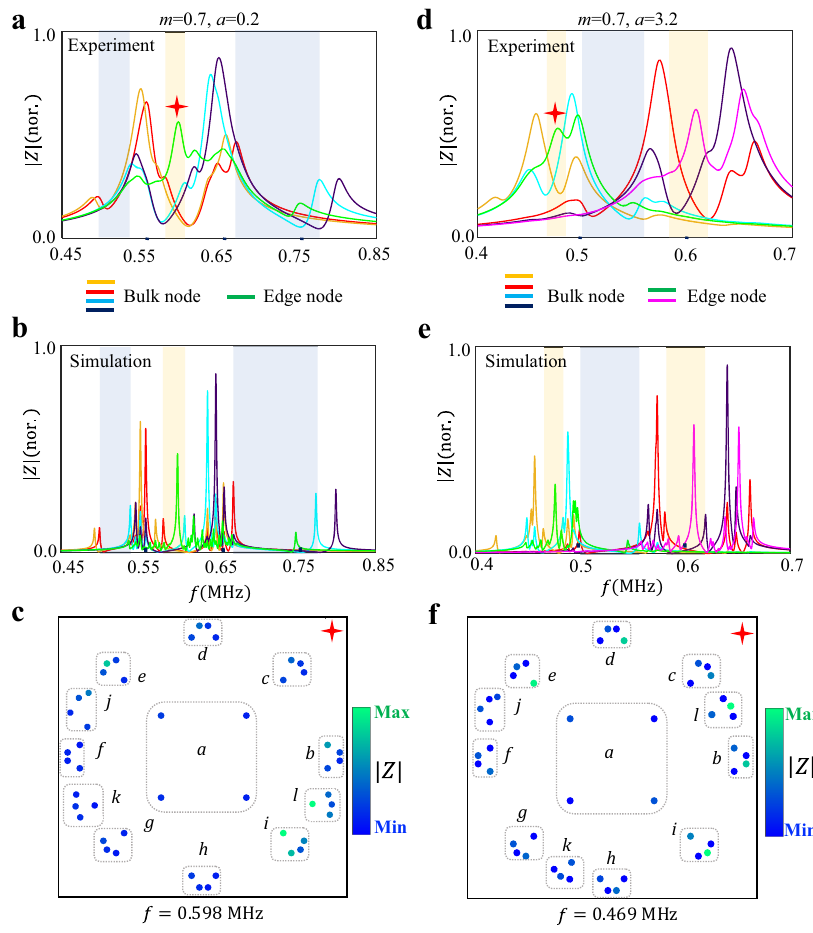
Fig. 4 | Experimental results on hyperbolic topology edge states induced by second Chern numbers in arti fi cial circuit networks with partially OBCs. a , b The measured and simulated impedance responses of bulk and boundary nodes in the hyperbolic circuit with the mass term being ( m =0.7, a =0.2) under partially OBCs. Here, four bulk nodes correspond to four sublattices in ‘ a ’ unit cell and the boundary node is the sub-node with the effective onsite potential being − m + a in the ‘ l ’ unit. c Themeasured spatialimpedancepro fi le at0.598MHzof the hyperbolic circuit with mass term being ( m =0.7, a =0.2). d , e The measured and simulated impedance responses of bulk and boundary nodes in the hyperbolic